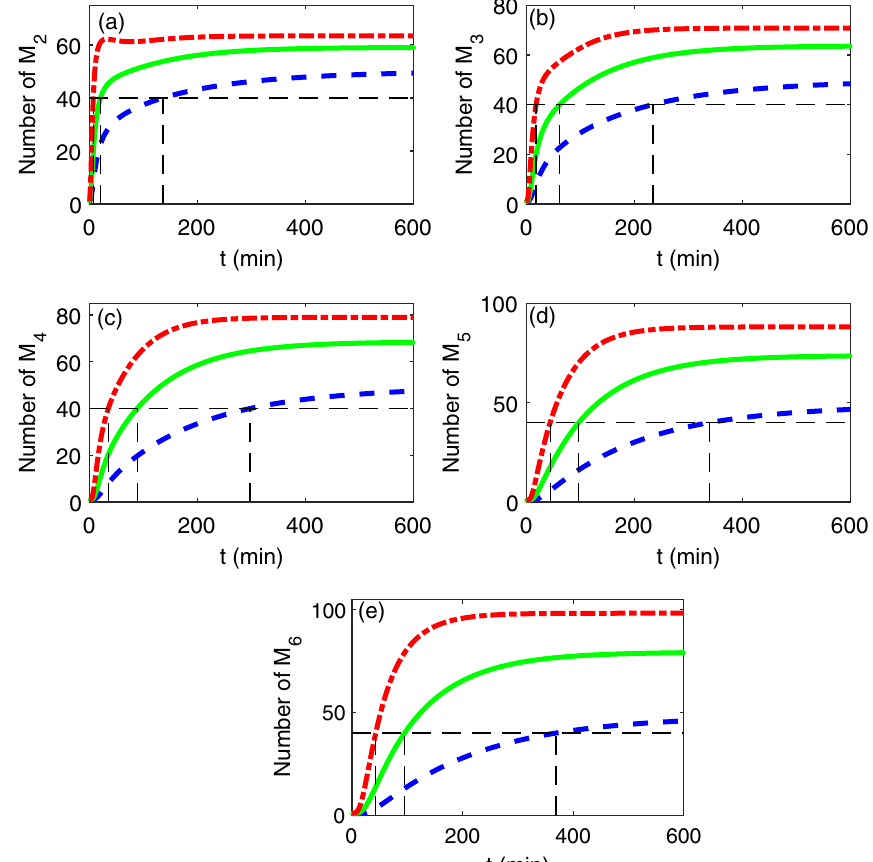
Figure 4. The time evolution of the number of different tapes of oligomers obtained by the moment closure method for different misfolding rate K 0 : K 0 = 0.005 (blue broken line), K 0 = 0.01 (green solid line) and K 0 = 0.02 (red dotted dash line). The horizontal dotted line represents a given level of the number of oligomers, while the vertical dotted line represents the time required to reach the given level. The other parameters are same as Fig. 2. The results by SSA are based on 10,000